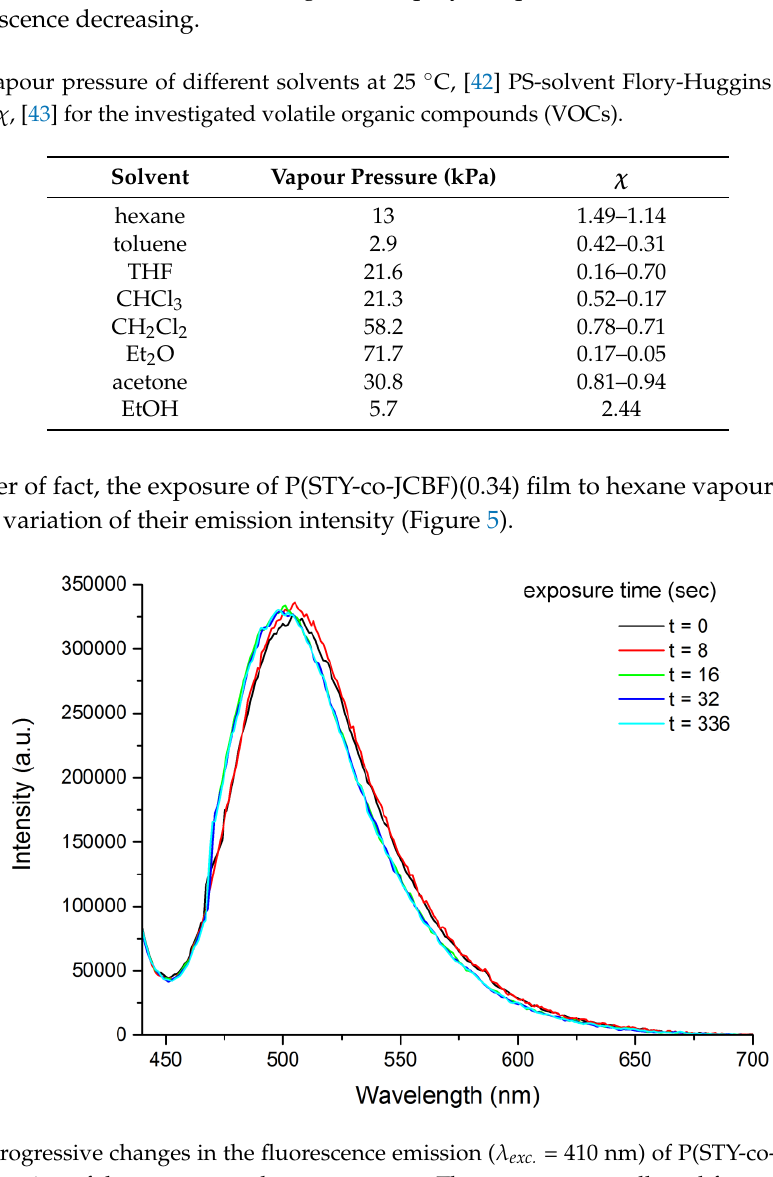
Figure 5. Progressive changes in the fluorescence emission ( λ exc. = 410 nm) of P(STY-co-JCBF)(0.34) film as a function of the exposure to hexane vapours. The spectra were collected for a total time of 5–6 min.